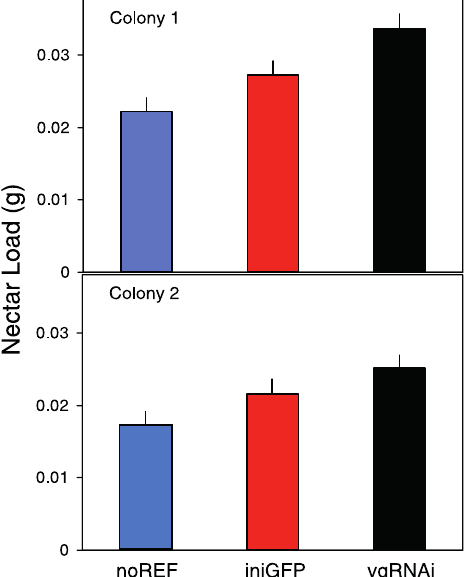
Figure 3. Effect of vitellogenin Gene Activity on Size of Nectar Loads Collected Knockdowns (vgRNAi) collected more nectar than injected controls (injGFP; ANOVA, F 1,315 ¼ 6.79, p , 0.010). The difference between injected controls and non-injected reference (noREF) bees was also significant (ANOVA, F 1,313 ¼ 6.00, p , 0.015). Bars are means with